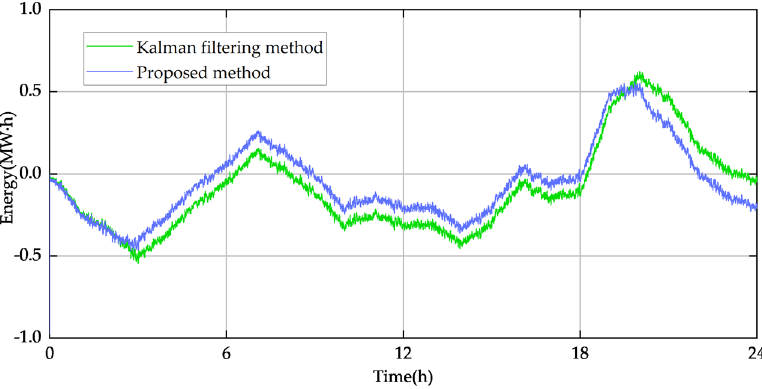
Figure 20. The energy change curve of the battery.